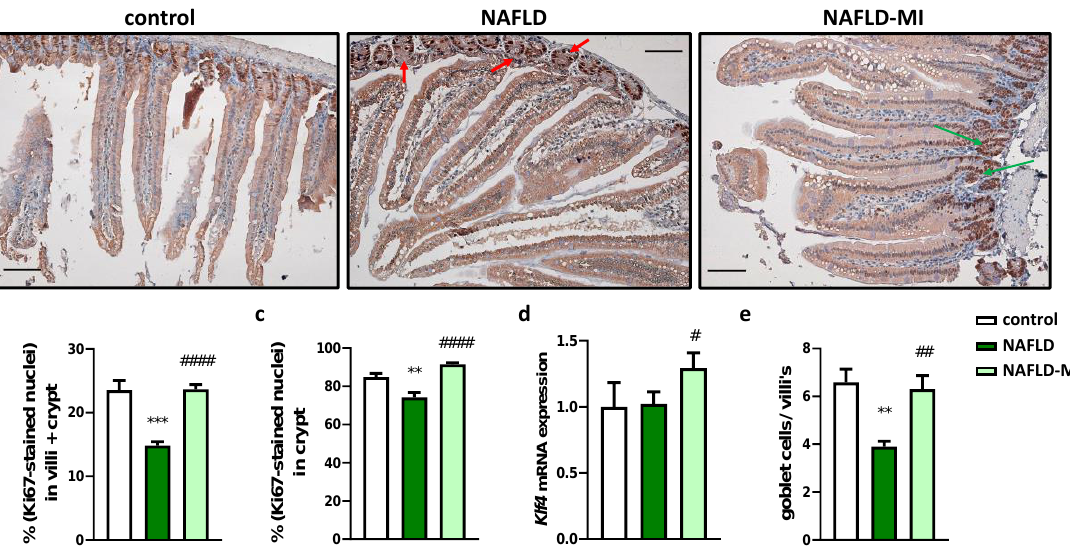
Figure 3. NAFLD mice showed an ectopic localization of proliferative cells which is recovered after MI supplementation. ( a ) Immunohistochemical analysis of small intestine sections of prolif- erating cells with Ki-67. Red arrows show the reduction of proliferative cells in crypts in NAFLD compared to the control group. Green arrows show the recovery of proliferation cells’ localization after MI supplementation. Moreover, in MI-supplemented mice and control mice, proliferative cells were detected in the villus. Bar = 200 µm. ( b ) Percentage of ki-67-stained nuclei in villus and crypts compared to other types of cells, and ( c ) the percentage of ki-67-stained nuclei just in crypts. Improvement of mucosa function was evaluated by intestinal mRNA expression of Klf4 (Kruppel-like factor 4) ( d , e ) goblet cells count. Data are mean ± SEM. ** p < 0.01, *** p < 0.001 vs. control mice; # p < 0.05, ## p < 0.01, #### p < 0.0001 vs. NAFLD mice.